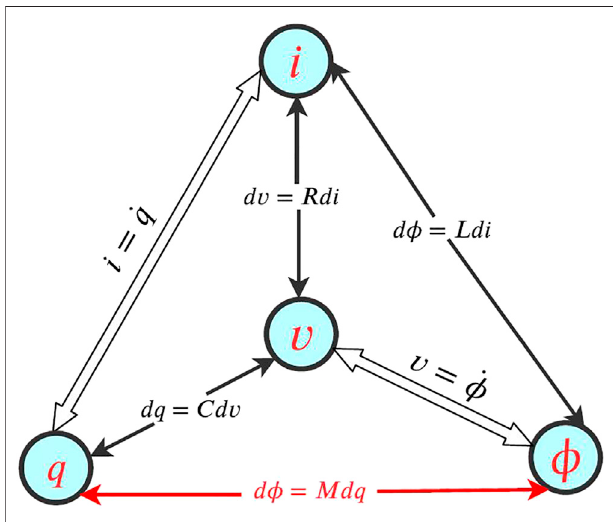
FIGURE 1 | Symmetrical argument of the four basic passive circuit elements with respect to the four circuit